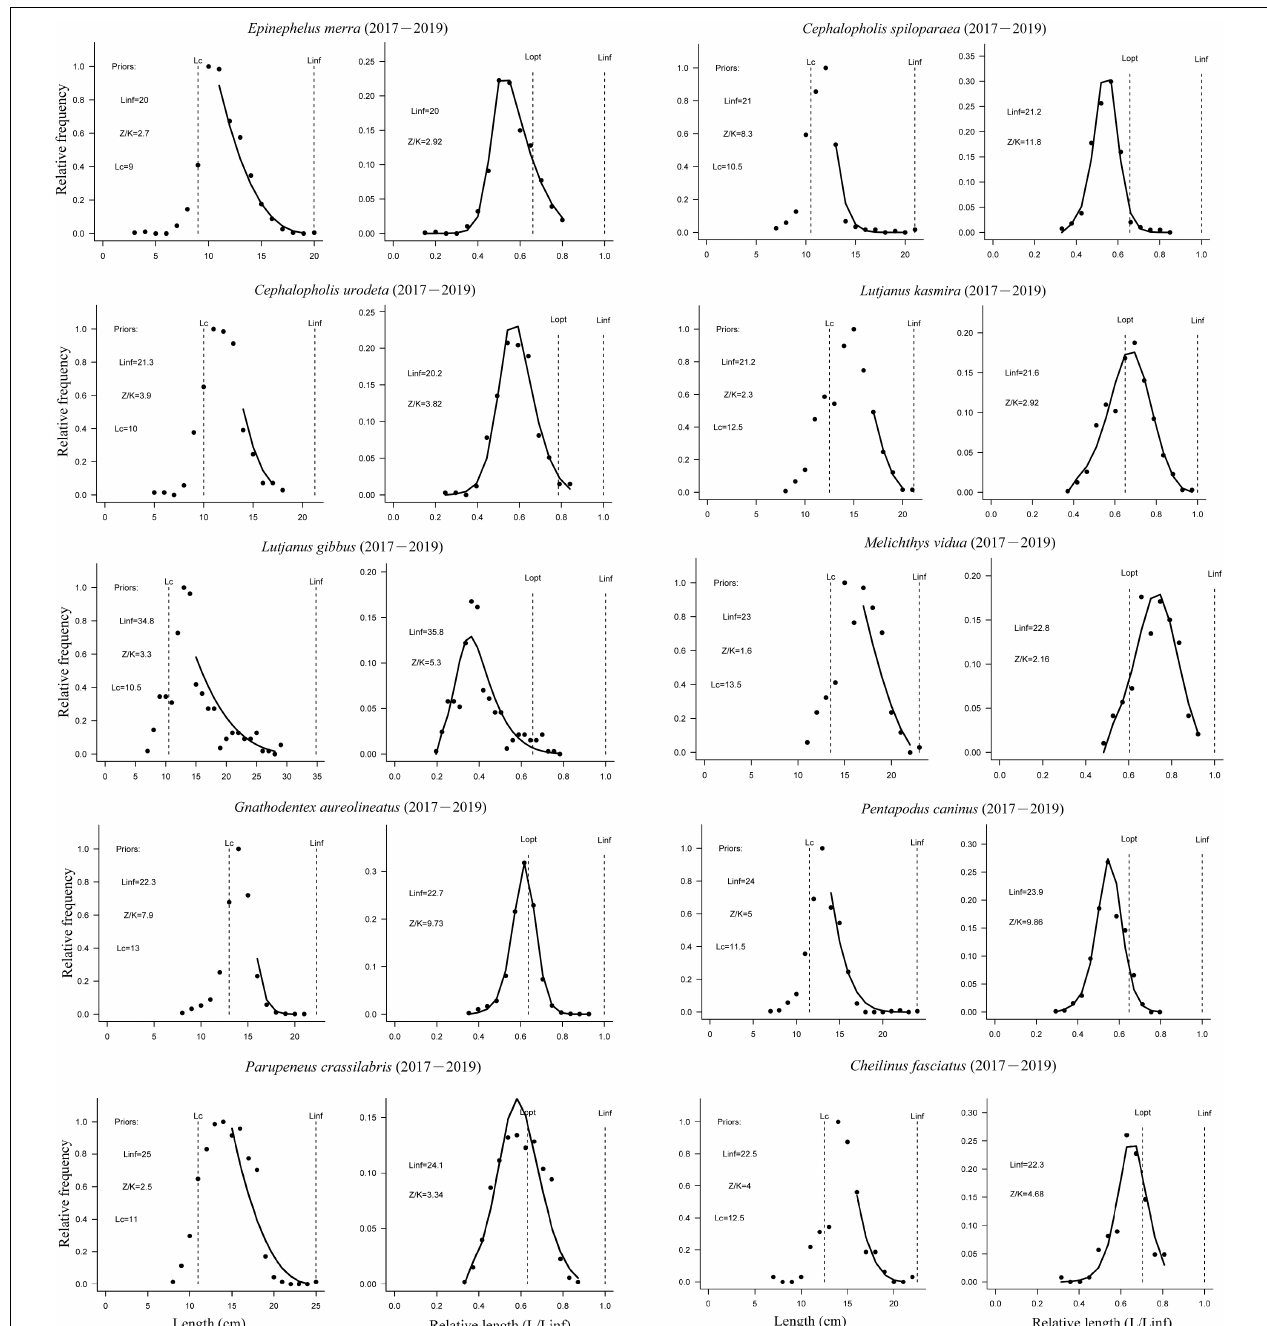
FIGURE 3 | Length-based Bayesian biomass analyses of 10 coral reef fish species from Nansha Islands, South China Sea. The left curves show the fits of the model to the length data; the right curves are the predictions of the LBB analysis, L c is the length of 50% individuals captured by the gear, L inf is the asymptotic length, and L opt is the length where the maximum biomass of the unexploited stock is obtained.